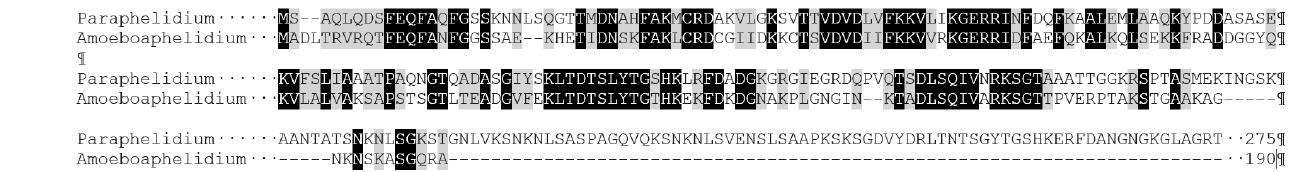
Figure 5. Sequence alignment of Paraphelidium tribonematis TRINITY_DN24782 and Amoeboaphelidium protococcorum KAI3631655 proteins by Clustal Omega [15]. Amino acids that are identical and biochemically similar are labeled by a black and grey background, respectively.